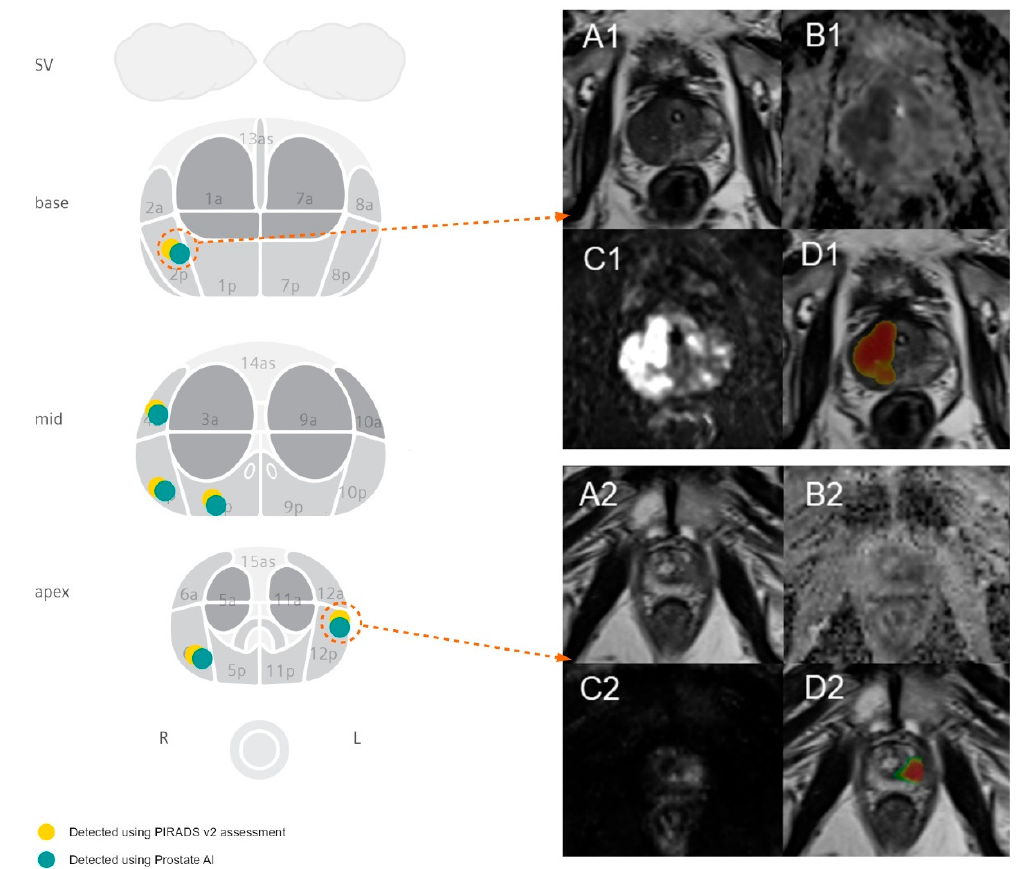
Figure 3. Figure showing the visualization of the automated detection of PI-RADS 5 lesions with positive biopsy results in the peripheral zone in two exemplary cases. The left-hand-side image visualizes the spatial distribution of lesions in our study cohort with a positive biopsy result. Case 1 ( A1 – D1 ) demonstrates a PI-RADS 5 lesion in the left mid-gland PZpl / PZa with a maximum diameter of 35.0 mm and a mean ADC value of 758 s / mm 2 for 62-year-old men, using the deep learning algorithm. Biopsy results revealed a Gleason 4 + 3 = 7 pattern. Case 2 ( A2 – D2 ) demonstrates a PI-RADS 5